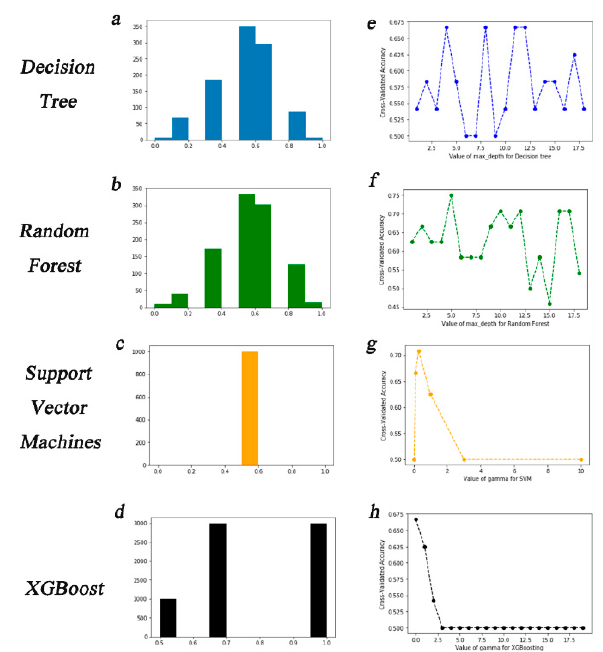
Figure 4. Evaluation results of di ff erent algorithms. Prediction accuracy of randomly selected test samples (1000 replicates) was calculated for decision tree ( a ), random forest ( b ), support vector machines ( c ), and XGBoost ( d ). The cross-validated accuracy was calculated with the values of max_depth from 1 to 18 for decision tree ( e ) and random forest ( f ), for gamma values from 1 to 10 for the support vector machines ( g ), and gamma values from 1 to 18 for XGBoost ( h ).